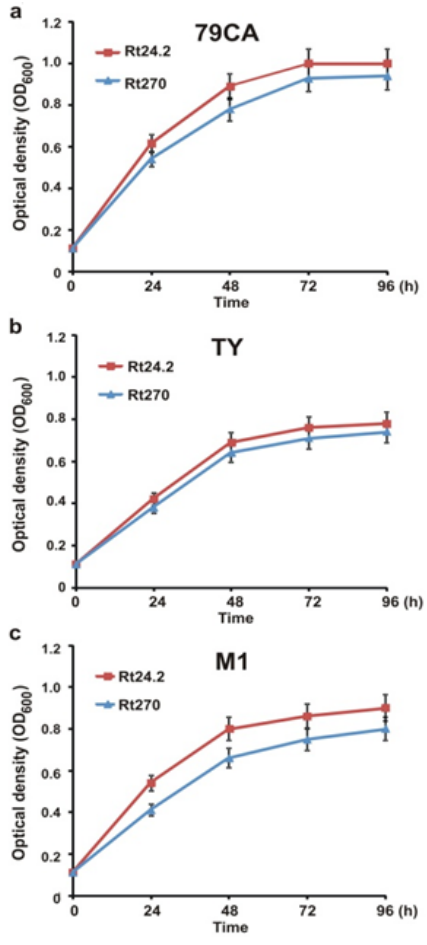
Figure 3. The growth of the Rhizobium leguminosarum bv . trifolii wild-type Rt24.2 and the pssA mutant Rt270 in rich 79CA ( a ) and TY ( b ) media and in minimal M1 medium ( c